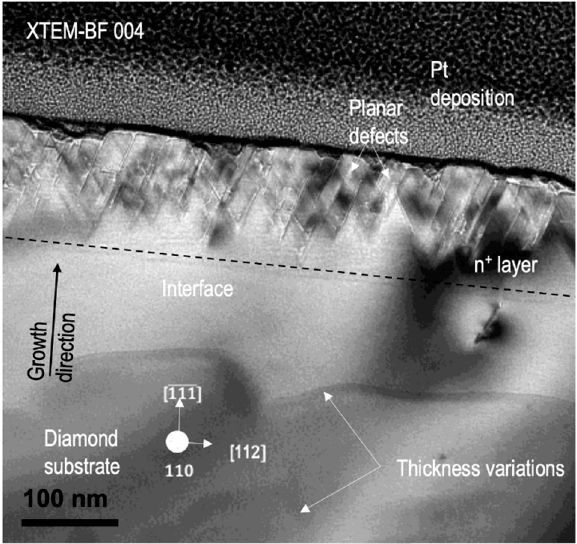
Figure 6. Diffraction contrast TEM micrograph, recorded with the 004 reflection, shows the for- mation of dislocations and planar defects above the interface for a heavily P-doped diamond epi- layer.